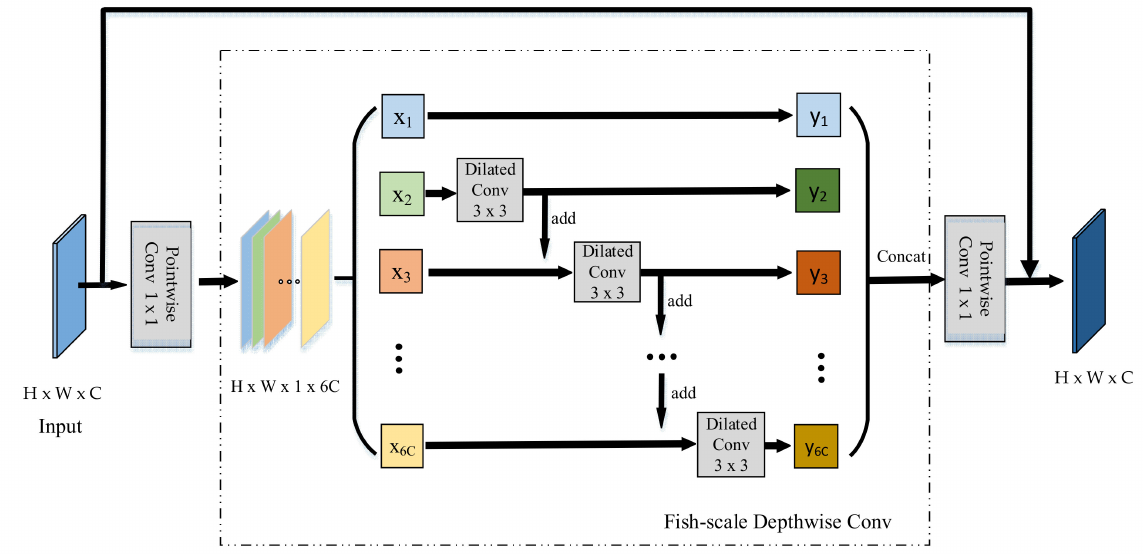
Figure 2. Skeleton of the fish-scale convolution block; H, W, and C denote the height, width, and channel dimension. The number of channels expand six times after point-wise convolution. After the depth dilated convolution, each layer feature is added into the next layer, and then dilated convolution of the next layer is conduct.